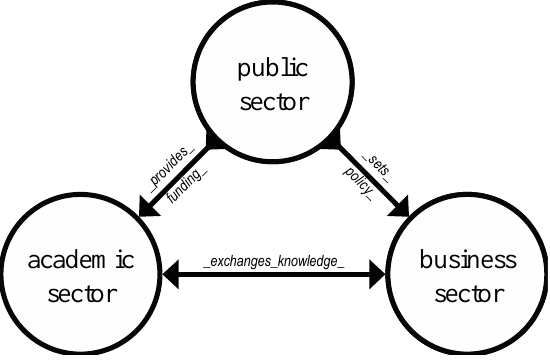
Figure 3. Emergence of the “triple helix” collaborative model adapted from Leydesdorff [24].